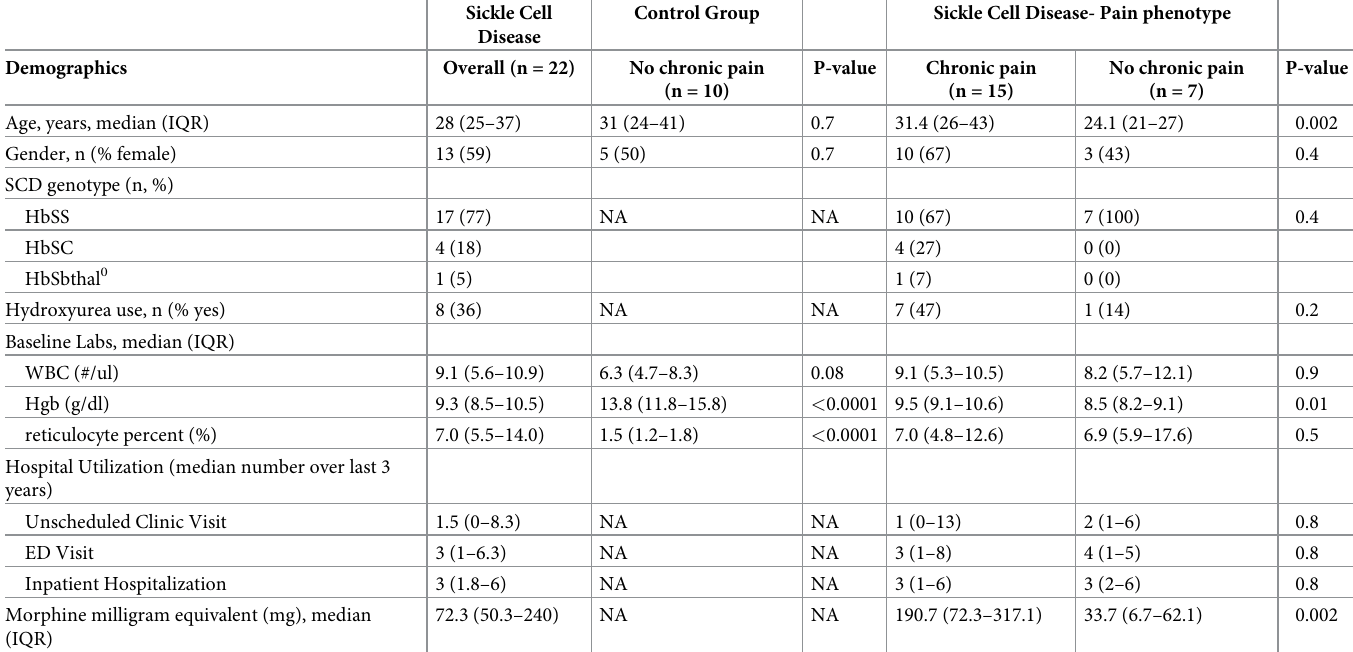
Table 1. Demographics for control subjects and patients with SCD with and without chronic